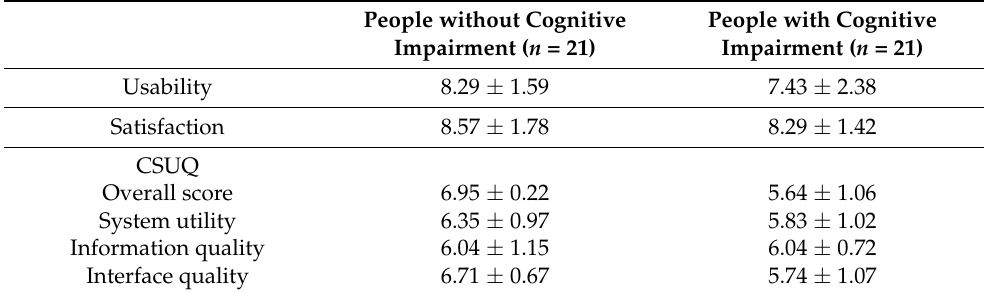
Table 2. Usability (1–10) and satisfaction (1–10) scales, as well as CSUQ